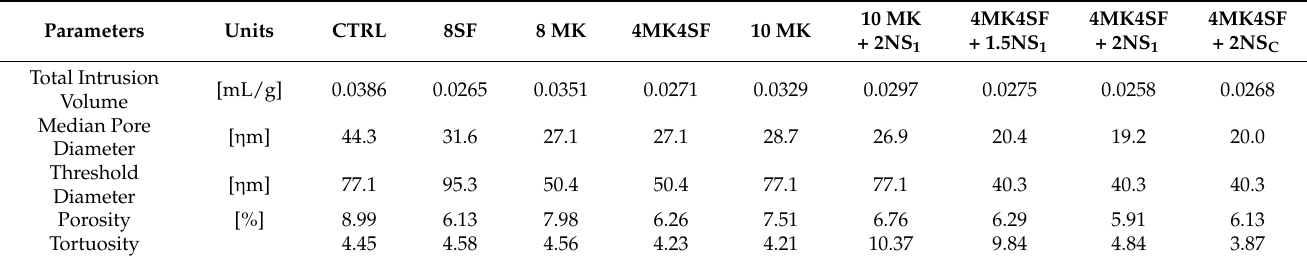
Table 5. Parameters of the mercury intrusion porosimetry tests at 28 days.